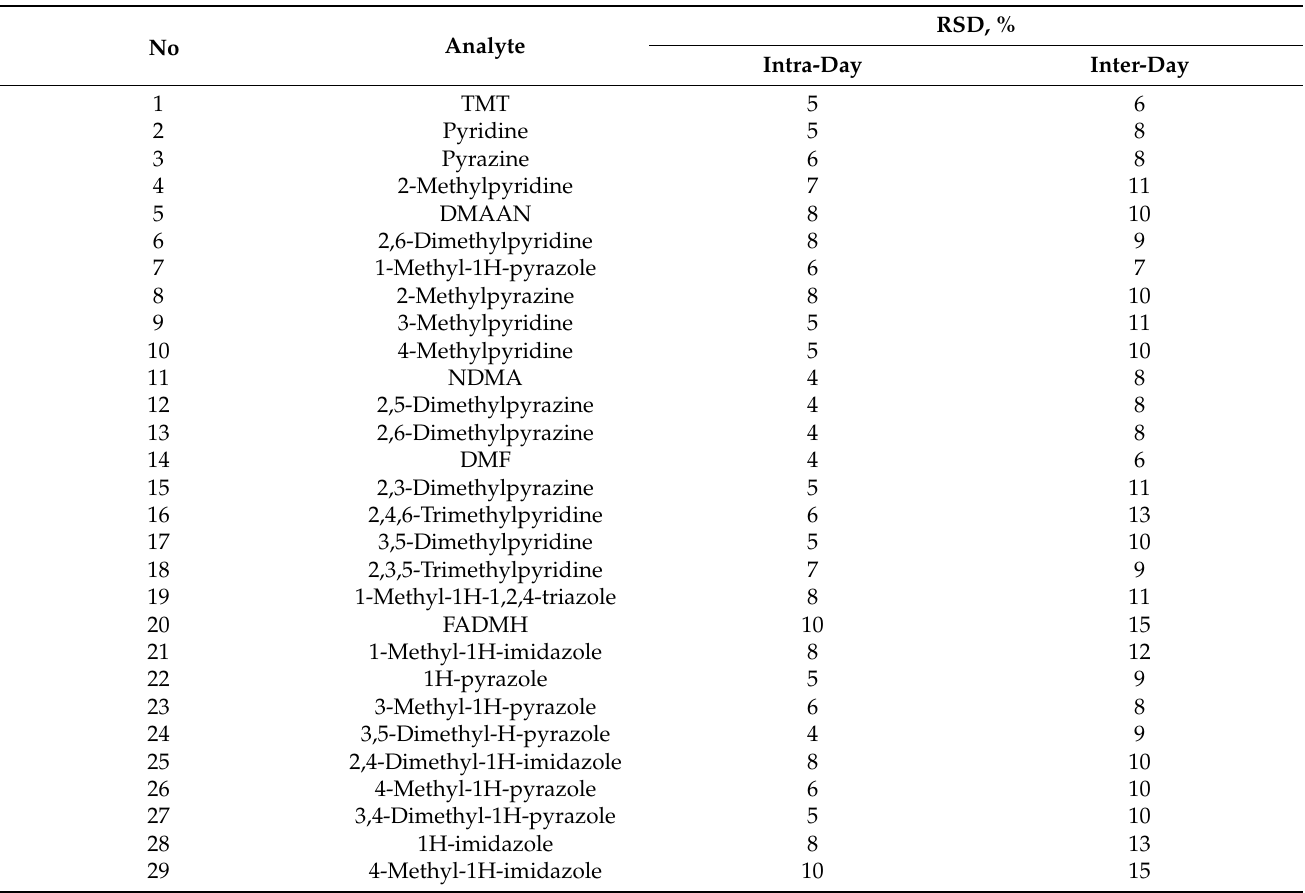
Table 2. Intra-day (24 h, n = 6) and inter-day (48 h, n = 6) precision of the developed AWASP-GC-MS method (MRM detection